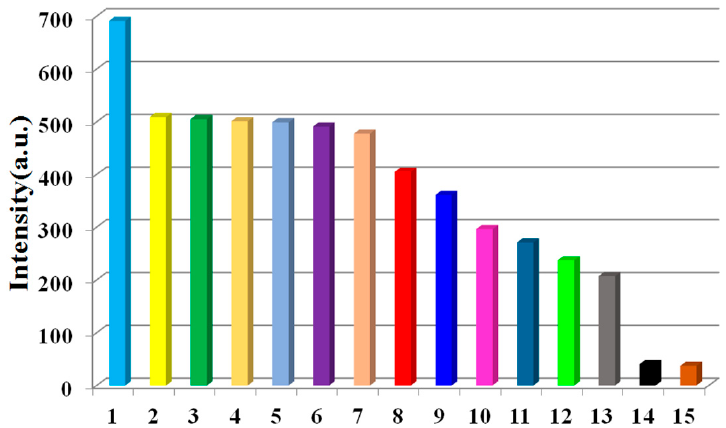
Figure 3. Fluorescence intensity map of complex 1 (1.5 mg) dispersed in aqueous solutions of diverse organic solvents (3 mL) excited at 275 nm: (1) methanol; (2) cyclohexane; (3) acetonitrile; (4) ethanol; (5) 1,4-dioxane; (6) ethyl acetate; (7) water; (8) dichloromethane; (9) trichloromethane; (10) ethylene glycol; (11) DMF; (12) tetrahydrofuran; (13) dimethyl sulfoxide; (14) methylbenzene; and (15) acetone.